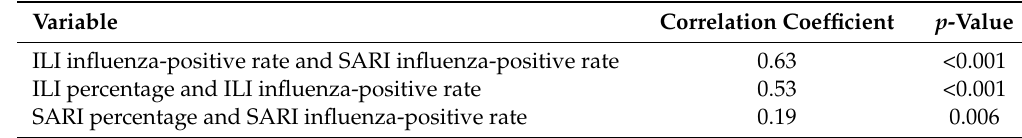
SARI percentage and SARI influenza-positive